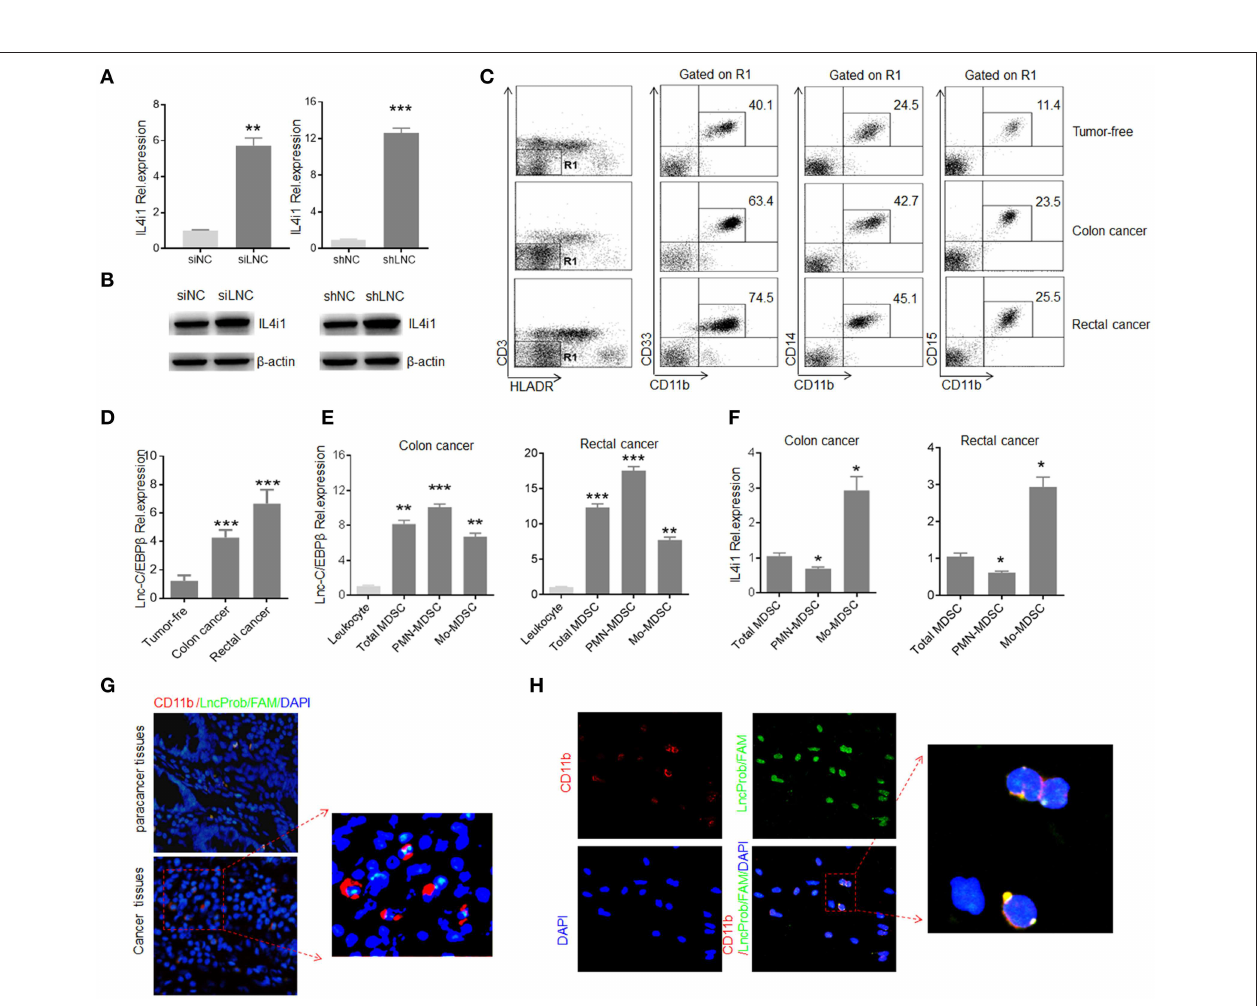
FIGURE 6 | Human lnc-C/EBP β has a similar function with mouse. (A) QRT-PCR of IL4i1 in lnc-C/EBP β knockdown human MDSC-like cells. (B) Immunoblotting of IL4i1 in lnc-C/EBP β knockdown human MDSC-like cells. (C) Flow cytometry of Lin − HLA-DR − CD14 + CD11b + MDSCs subsets in healthy individuals and patients with colon and rectal cancer. (D) QRT-PCR of human lnc-C/EBP β in MDSC subsets isolated from the human colon, rectal cancer and healthy individuals. (E) QRT-PCR of human lnc-C/EBP β in MDSC subsets isolated from the human colon and rectal cancer. (F) QRT-PCR of human IL4i1 in MDSC subsets isolated from the human colon and rectal cancer. (G) Immunostaining and RNA-FISH in the human colon cancer and para cancer tissues. Red, CD11b; Green, lnc-C/EBP β ; Blue, nuclei. One representative of 12 patients with colitic cancer. Scale bar = 200 µ M. (H) Immunostaining and RNA-FISH in the peripheral blood Lin − HLA-DR − CD33 + CD11b + MDSCs in the patients with colon cancer. Red, CD11b; Green, lnc-C/EBP β ; Blue, nuclei. One representative of 12 patients with colitic cancer. Scale bar = 200 µ M. siNC, siRNA control; siLNC, lnc-C/EBP β siRNA; shNC, empty lentiviruses; shLNC, lnc-C/EBP β shRNA/lentiviruses. Error bars in (A,D–F) represent standard deviations from 3 independent measurements. Two-tailed, paired T -test was used in (A,D–F) . * p < 0.05; ** p < 0.05; *** p < 0.001. NS, no significant.